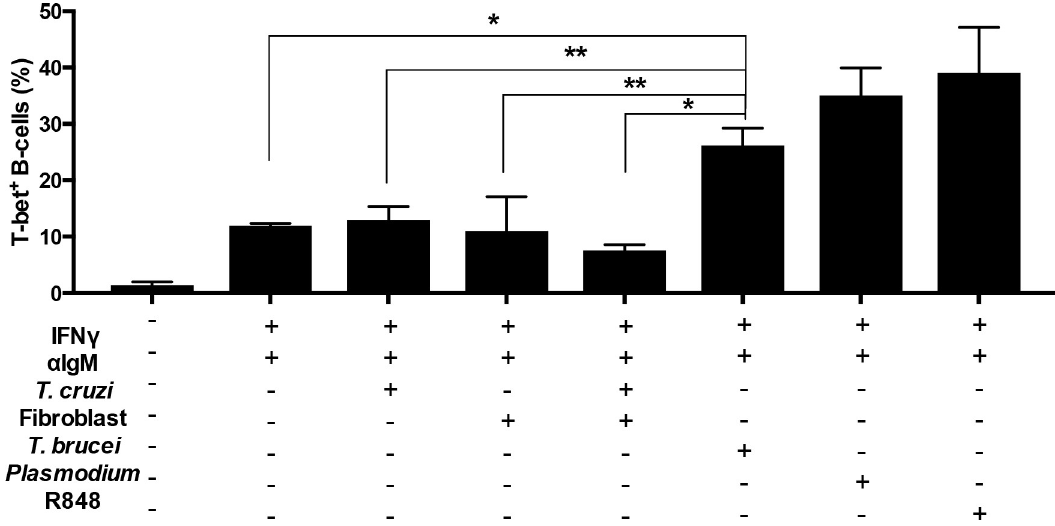
Fig 5. IFN γ synergizes with trypanosome molecules to induce T-bet expression on B cells in-vitro . Purified naive B cells (CD43 − ) from uninfected mice were cultured under the indicated conditions for 3 days, when T-bet expression was determined in CD19 + cells. Agonist of TLR7 (R848). Experiments were repeated 2 times, one representative example is shown. Bars represent the means ± SD of n = 3 mice. Significance determined by one-way ANOVA. � p < 0.05, �� p <